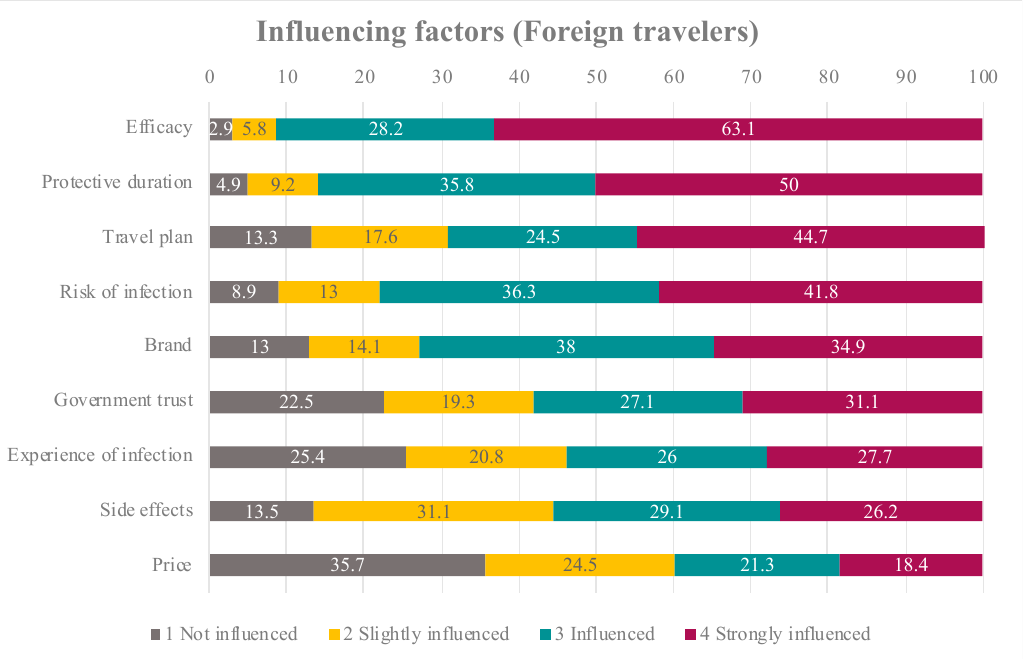
Figure 4. The percentages of influencing factors among foreign (non-Thai) travelers.